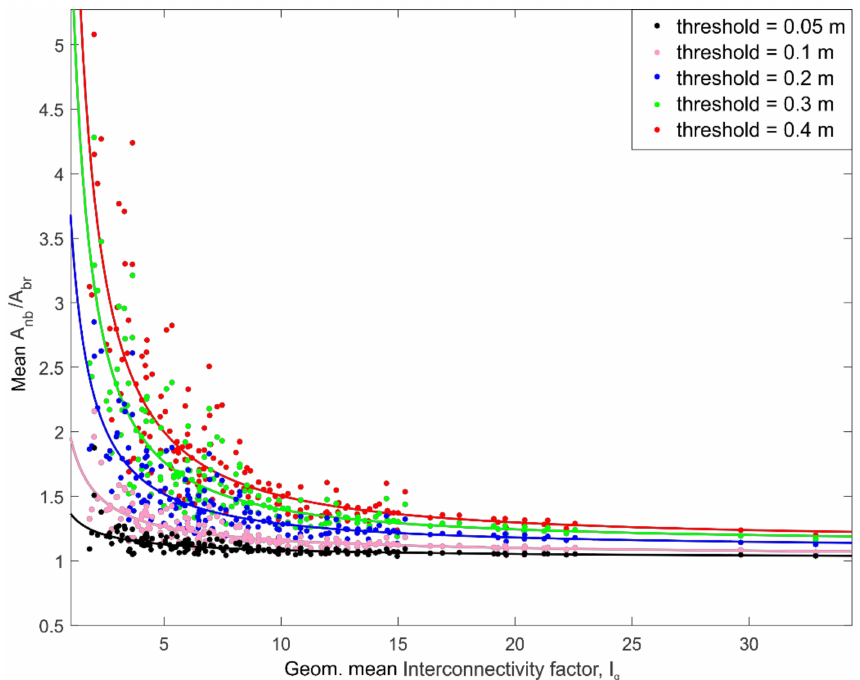
Figure 8. Correlation between the geometric mean interconnectivity factor, I g , and the ratio between the mean surface areas, A nb /A br (color-coded according to different thresholds). Power-law fit for the various data sets of similar threshold lengths are illustrated as lines and color-coded according to the